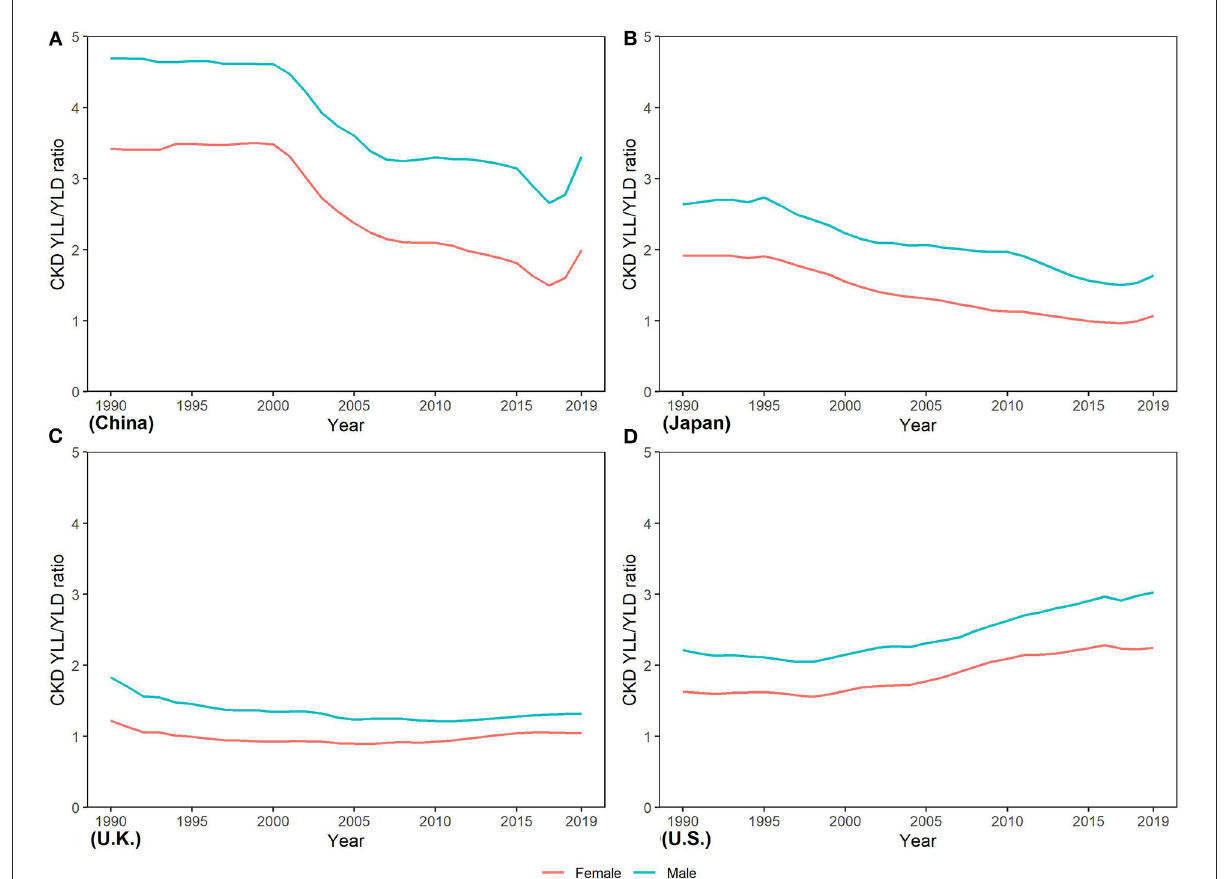
FIGURE7 Trends in years of life lost/years of the life disability ratio of CKD from 1990 to 2019 in (A) China (B) Japan, (C) U.K., and (D) the U.S.